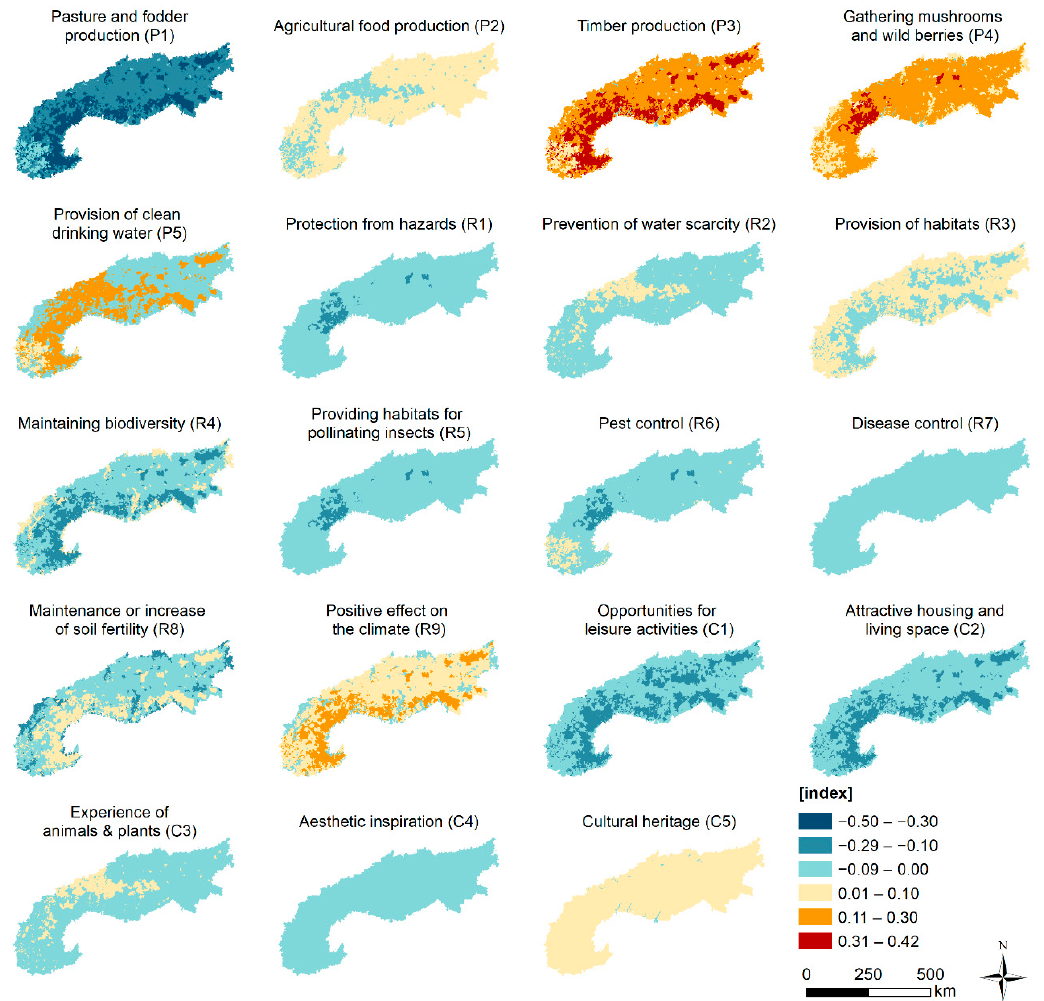
Figure 4. ES values in 2000 ( left ), 2018 ( center ), and change in ES value between 2000 and 2018 ( right ). Authors own elaboration.